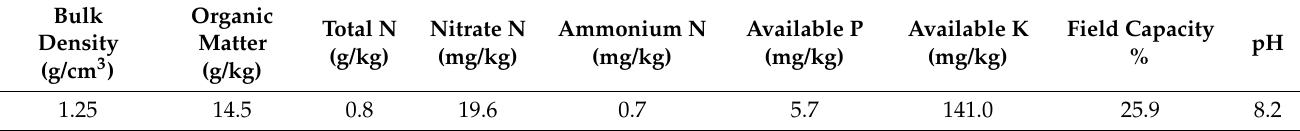
Table 1. Basic features of the soil used in the